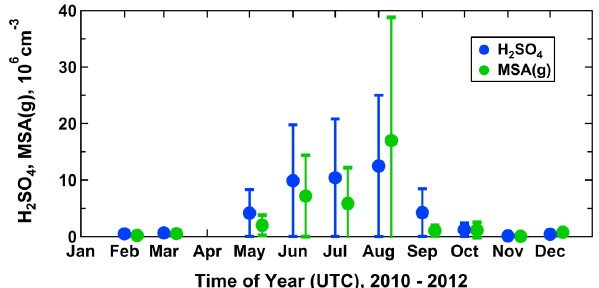
Figure 2. Midday (10:00–14:00UTC) maximum H 2 SO 4 and MSA(g) concentrations in marine air at Mace Head, averaged for each month (total measurement period: May 2010–August 2012). Vertical bars denote standard deviations.